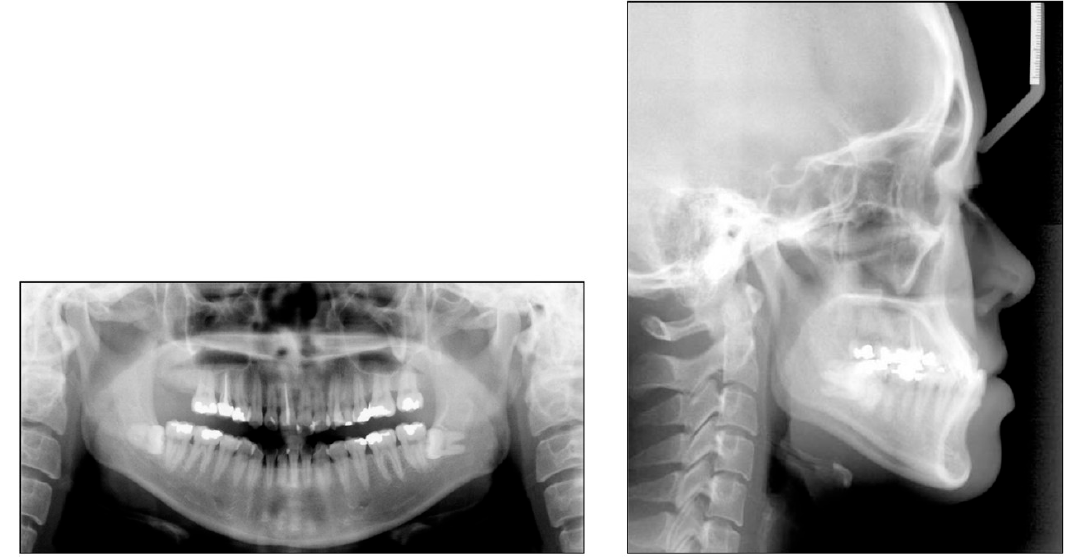
Figure 10. Case 2, Pretreatment panoramic radiograph and lateral